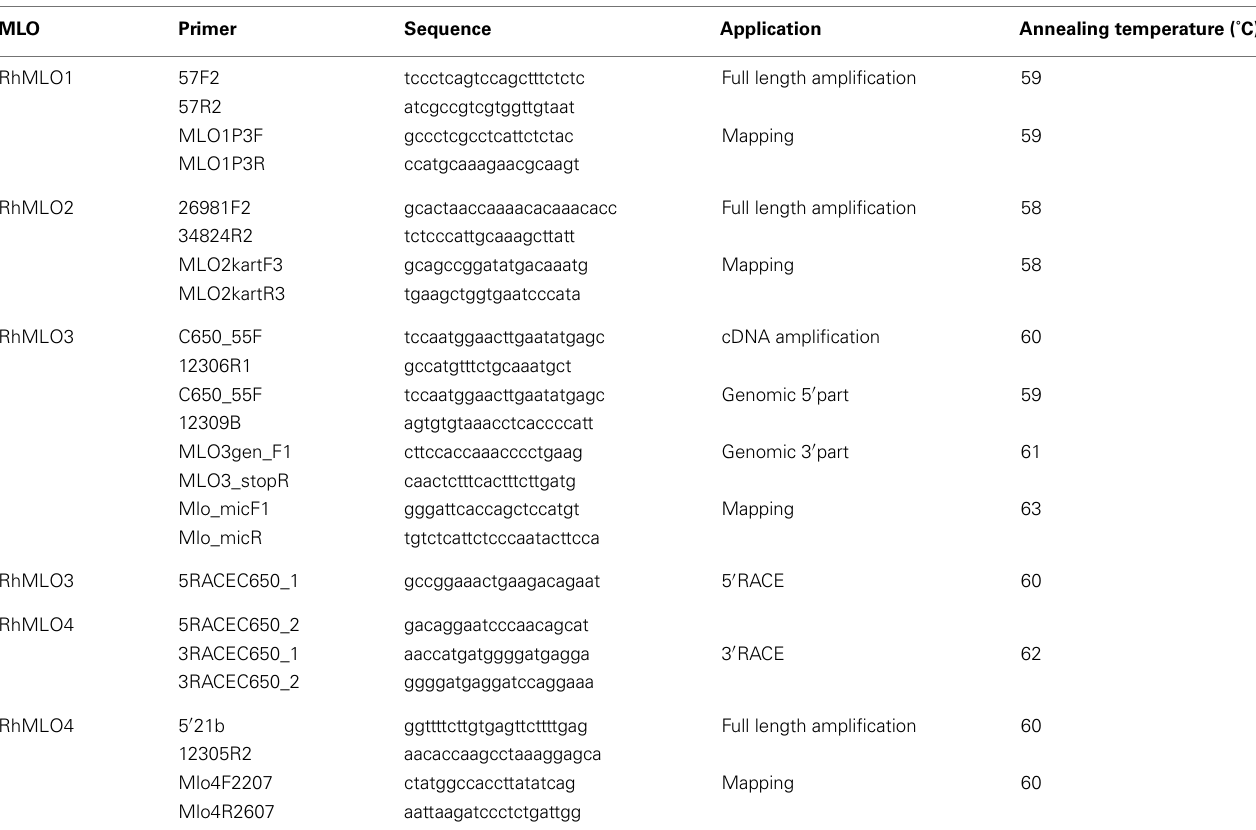
TableA1 | Primers used in the amplification of rose MLO